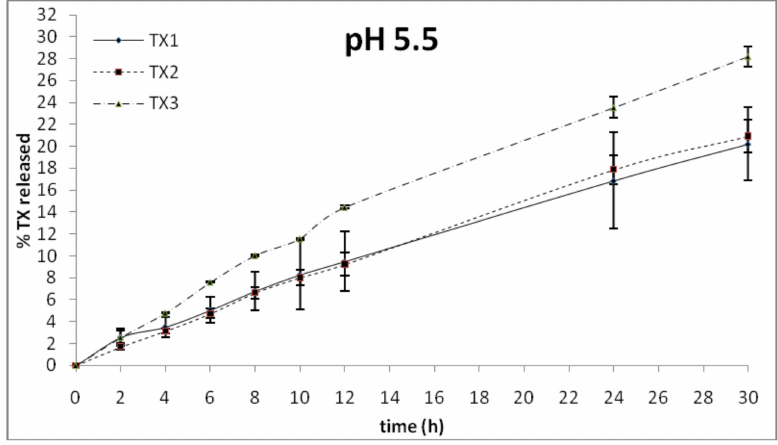
Figure 4. TX release profiles at pH